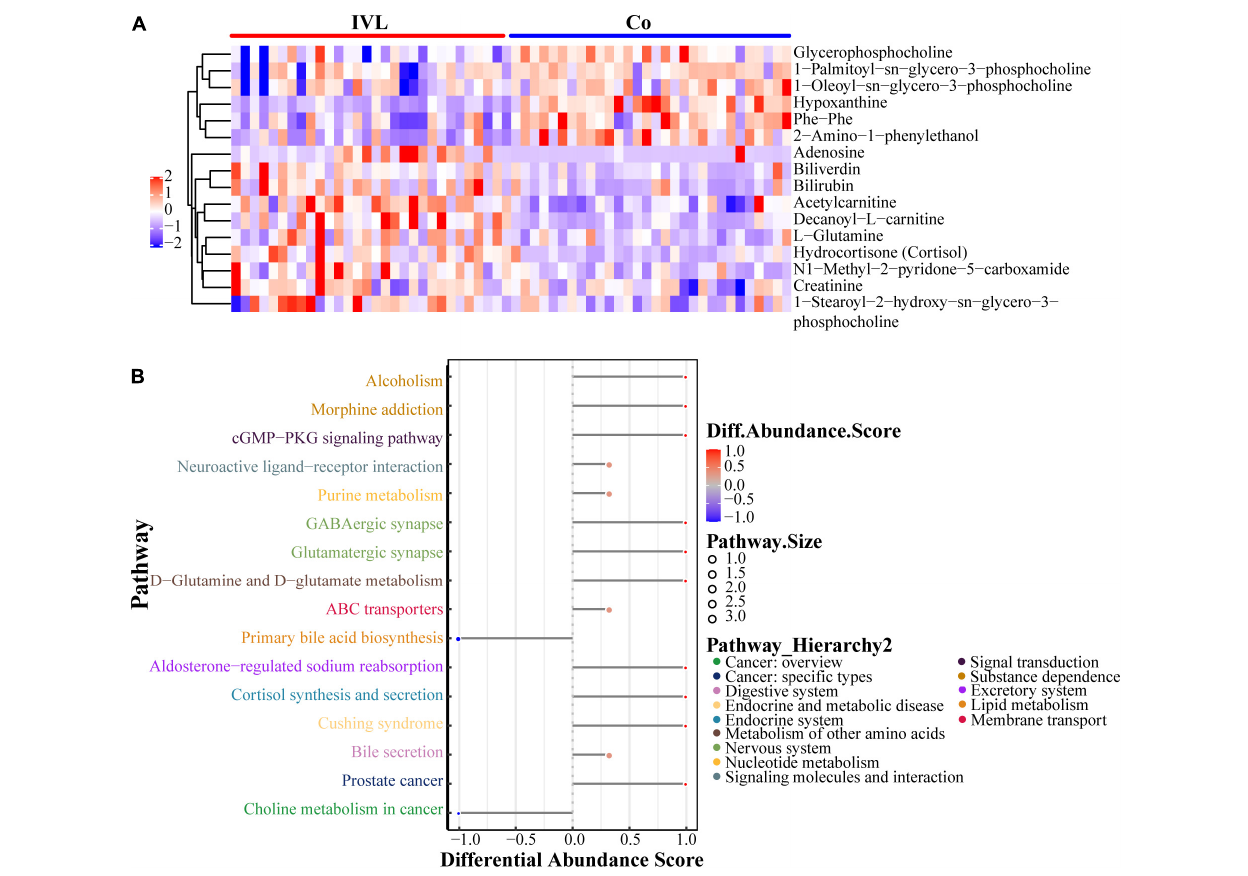
FIGURE 2 | Characteristics of 16 identified metabolites. (A) Heatmap visualization of metabolomics data with hierarchical clustering analysis in the positive ion mode. Colors reflected the relative content of metabolites in serum. The more similar the colors were, the more similar the expression pattern. The panel on the right indicated the different metabolites. Each blockage meant a sample of either the IVL or Co groups. (B) The differential abundance (DA) score of differential metabolic pathways. Y -axis represented the name of the differential pathways, and X -axis coordinates meant the DA score. DA score was defined as the total change of all metabolites in the metabolic pathway. A score of 1 indicated an upregulated expression trend for all identified metabolites in the pathway, while –1 was exactly the opposite. The length of the line segment represented the absolute value of DA score; the size of the dot at the end of the line segment referred to the number of metabolites in the pathway; the larger the dot was, the greater the number of metabolites. The color depth of the line segment and dot was proportional to DA